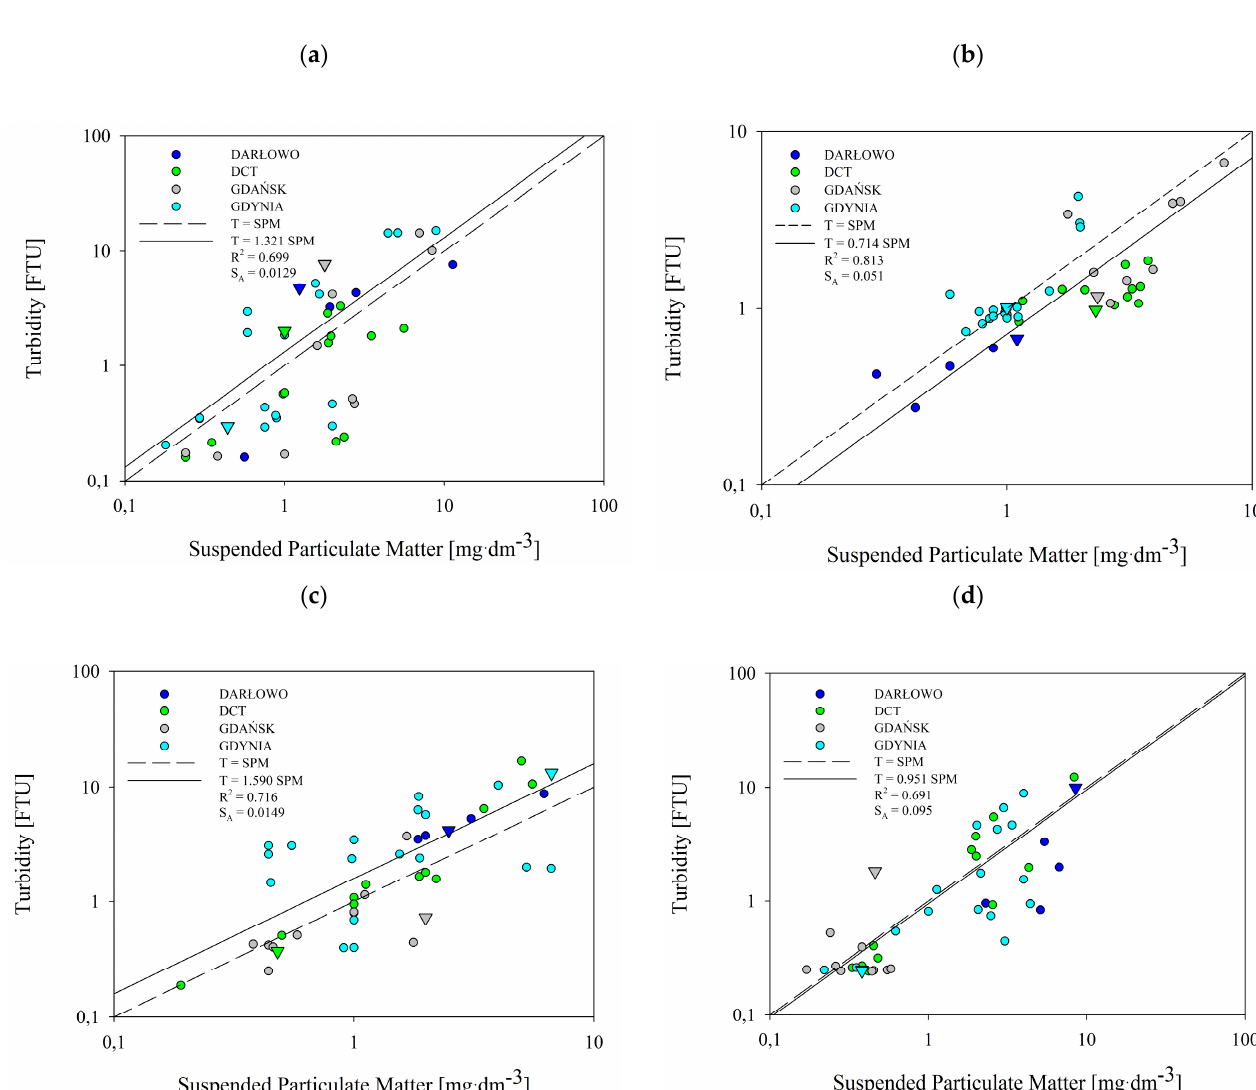
Figure 6. Correlations between in situ turbidity and the concentration of SPM in the near-surface layer for the spring ( a ), summer ( b ), autumn ( c ), and winter ( d ). Circles depict the sea dumping site points, while triangles depict reference points. Throughout this figure, T also means turbidity.